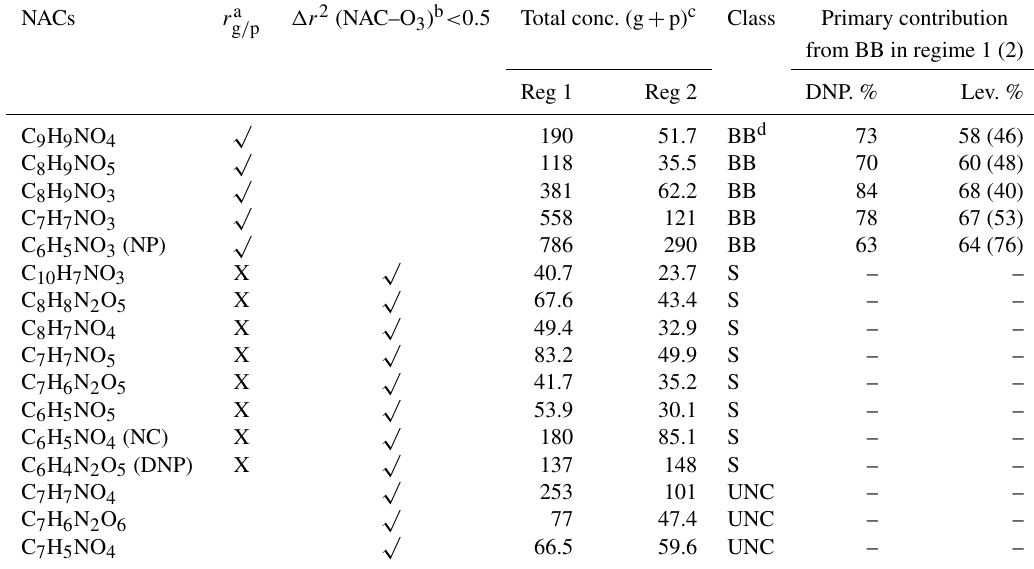
Table 1. Classification of the detected nitro-aromatic compounds based on their major formation pathways. (cid:49)r 2 (NAC–O 3 ) b < 0 . 5 Total conc. (g + p) c Class Primary contribution NACs r a g / p